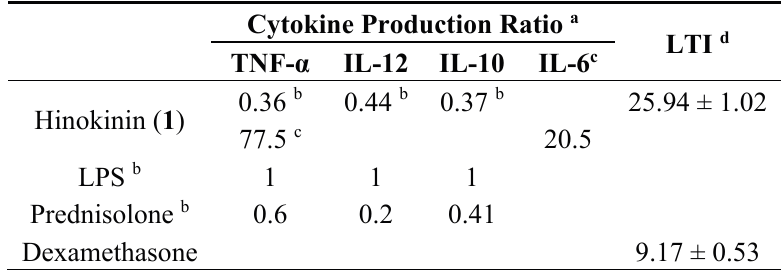
Table 2. Immunosuppressive activity of hinokinin ( 1